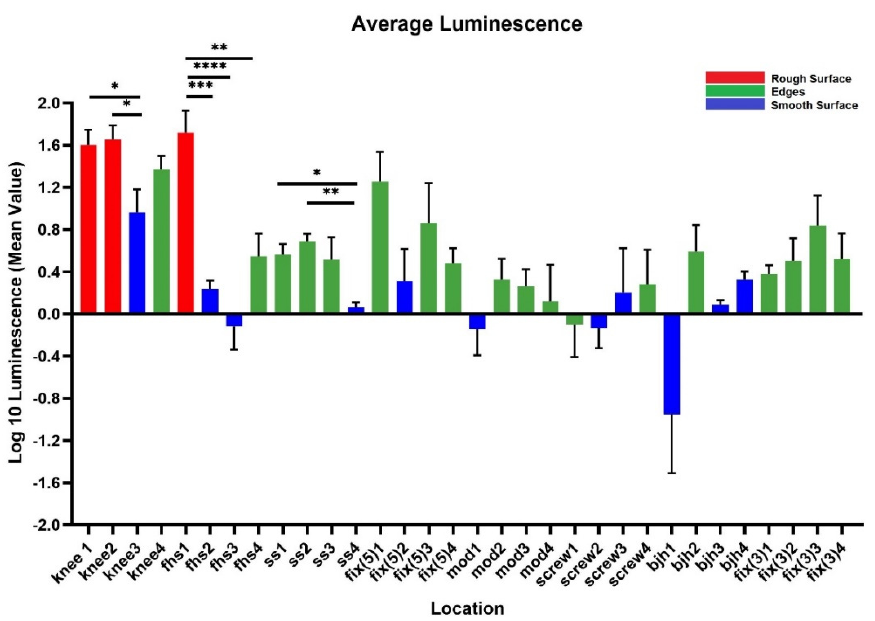
Figure 5. Compilation of mean luminescence of all implants. Individual graphs of each implant were combined to observe the trends across all implants. n ≥ 3; geometric mean ± SE. (* p < 0.05, ** p < 0.01, *** p < 0.001, **** p < 0.0001).